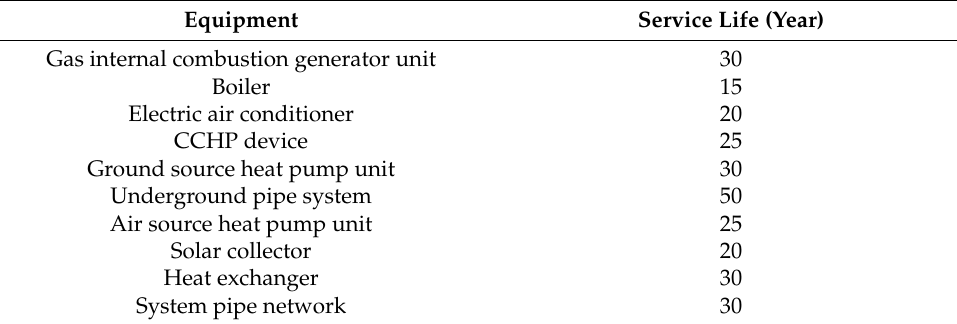
Table A9. Equipment service life.